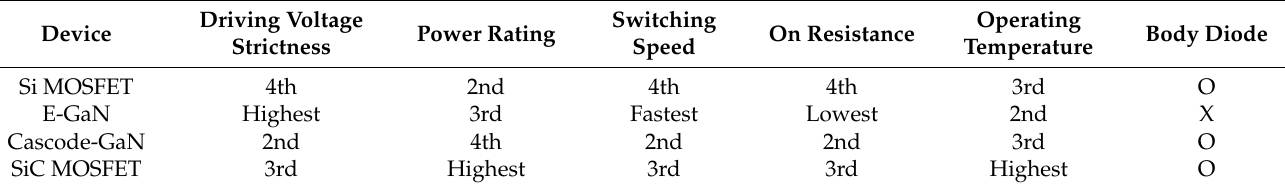
Table 2. General comparison of Si metal-oxide-semiconductor field-effect transistors (MOSFET), normally off GaN HEMTs, and SiC